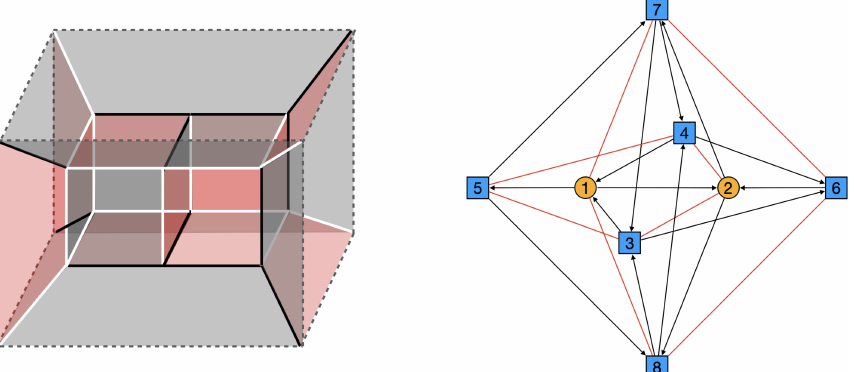
Figure 4 . A BFT 2 on a 3-ball and its dual quiver. Yellow round and blue square nodes correspond to gauge and global symmetry groups, respectively. Every plaquette in the dual quiver corresponds to a monomial in the